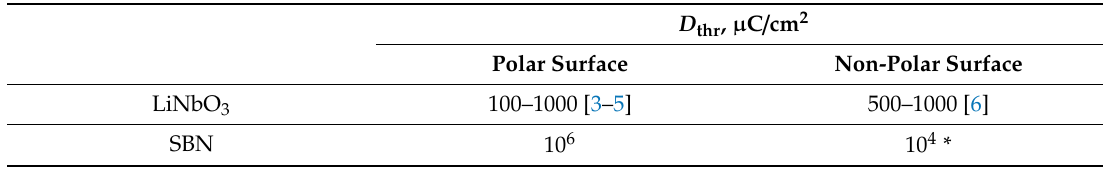
Table 1. The D thr value for electron-beam domain